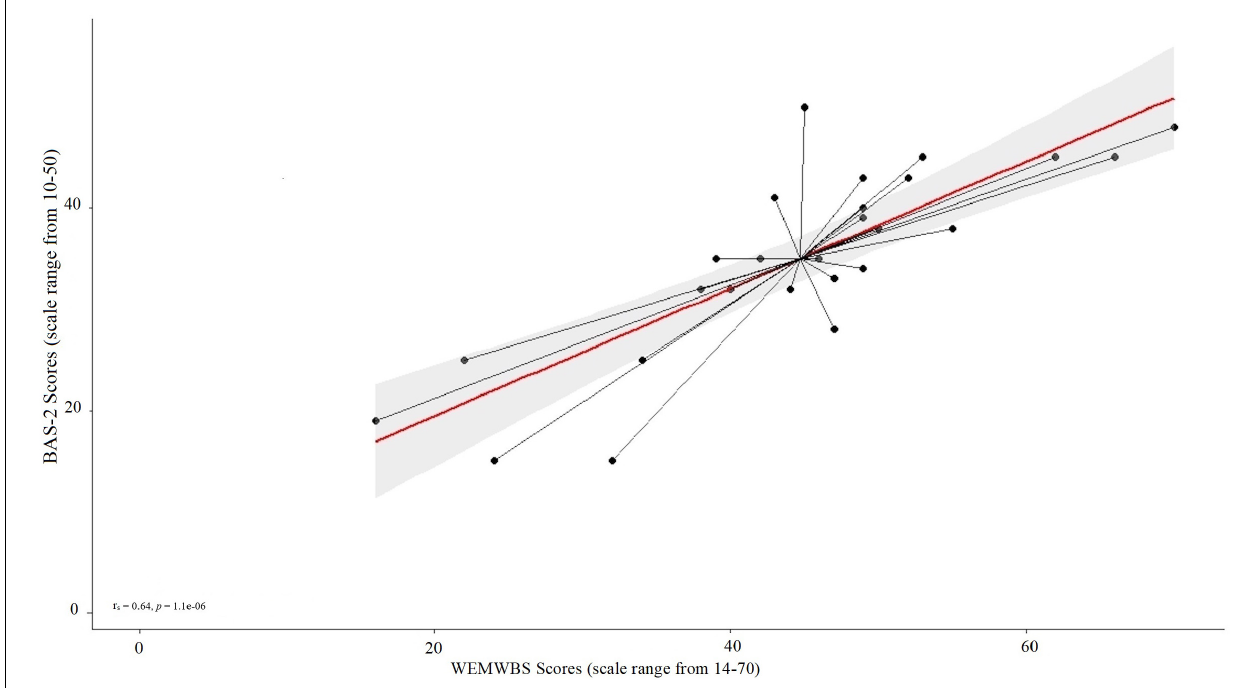
FIGURE 1 | Scatterplot of the mean values for the Parkinson’s sample of pre-intervention ratings on the wellbeing (WEMWBS; scale ranges from 14–70; a higher score indicates higher wellbeing) and the body appreciation scale (scale ranges from 10–50; a higher score indicates higher